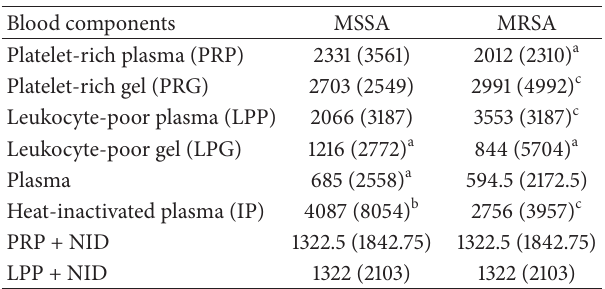
Table 2: PF-4 (pg/mL) concentration in every blood component cultured with either MSSA or MRSA at 6 hours.